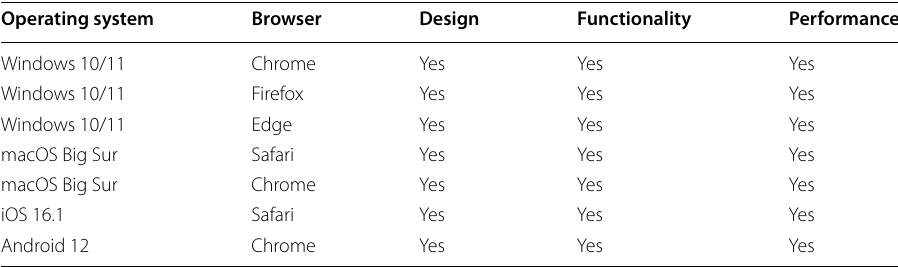
Table 1 Compatibility